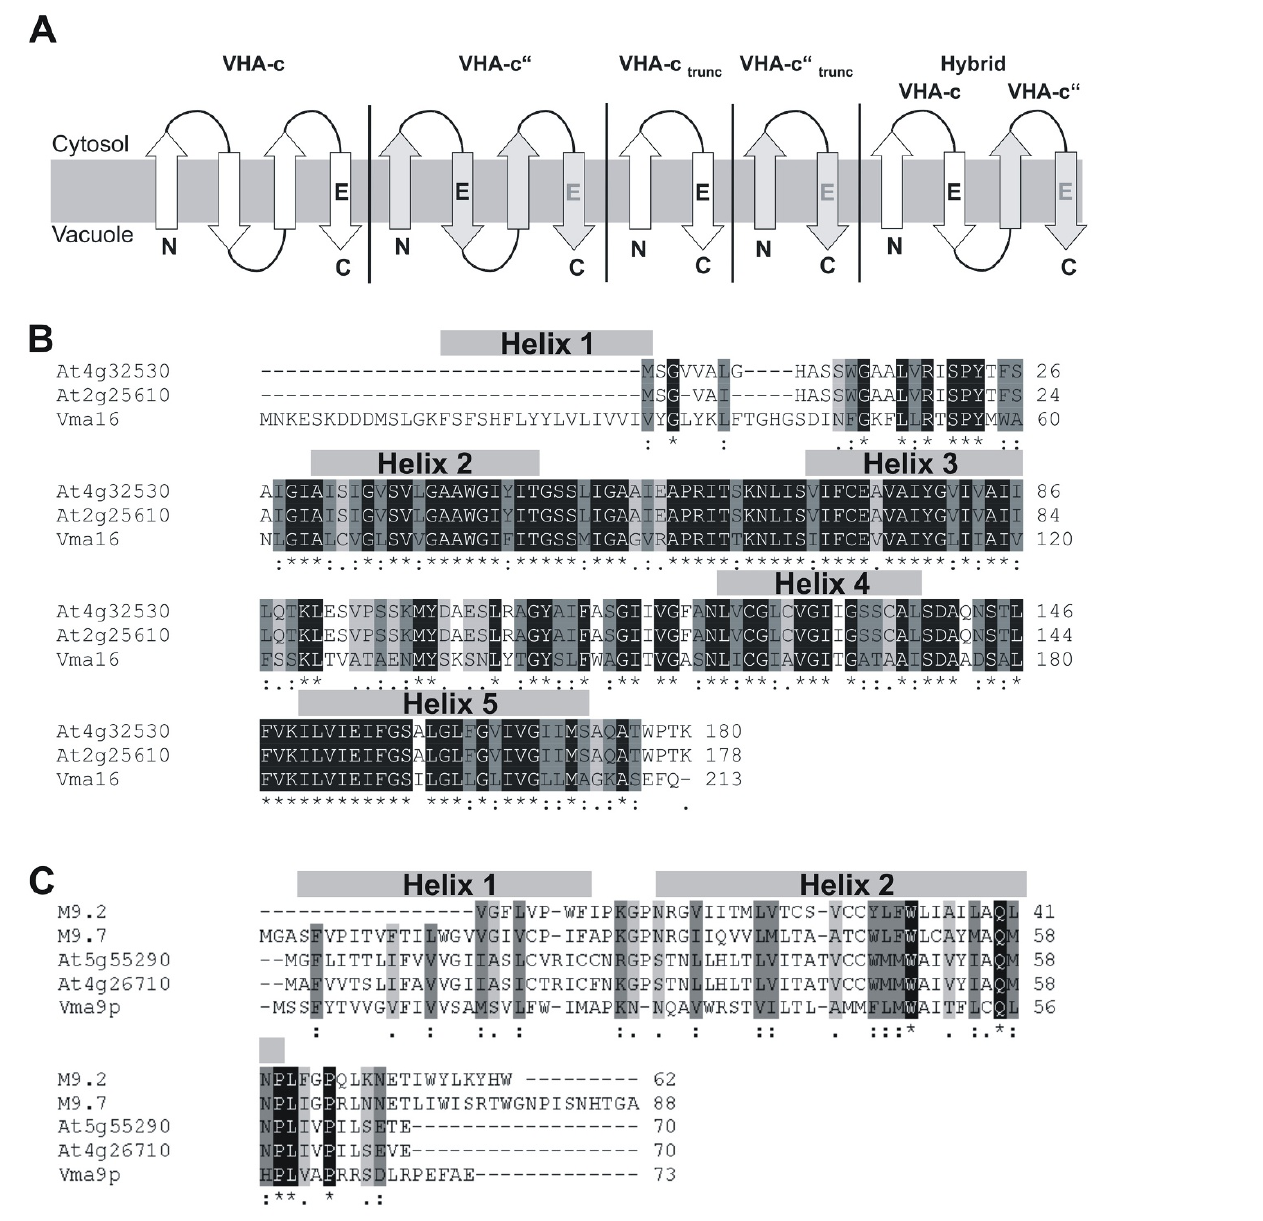
Figure 1 Topology of proteolipid constructs and alignment of the VHA-c" and VHA-e amino acid sequences . (A) Trans- membrane topology and localisation of conserved glutamate residues in various proteolipid isoforms or synthetic constructs, namely VHA-c3, VHA-c", VHA-c , VHA-c" and hybrid proteolipid subunit. The functional Glu is highlighted in black, non- functional in grey. (B) VHA-c" sequences from S. cerevisiae (Vma16, Q91V37) and A. thaliana (VHA-c"1: At4g32530, CAB79970; VHA-c"2: At2g25610, NP_180132). (C) VHA-e sequences from S. cerevisiae (Vma9p, NP_958835), Bos taurus (M9.2, CAA75570), Manduca sexta (M9.7, CAA06822) and both VHA-e isoforms in A. thaliana (isoform 1: At5g55290, NP_568823; isoform 2: At4g26710, CAB79526) were compared. The sequences were obtained from the NCBI database and aligned using the ClustalW program. Transmembrane segments were predicted using HMMTOP and marked by bars. Identical amino acid residues are marked by (*) and highlighted in black, similar residues by